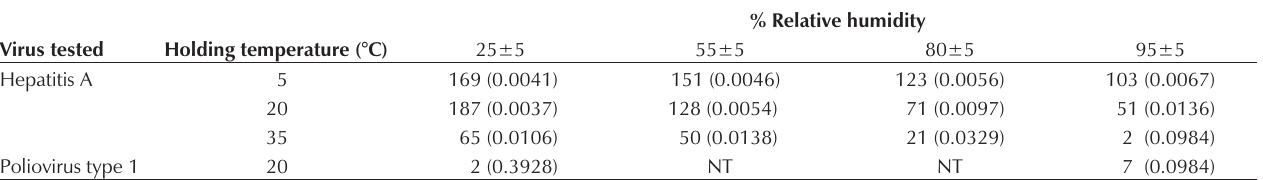
The half-lives in hours (K i values)* of hepatitis A virus (HM-175) and poliovirus type 1 (Sabin) on nonporous environmental sur- faces under various levels of air temperature and relative humidity